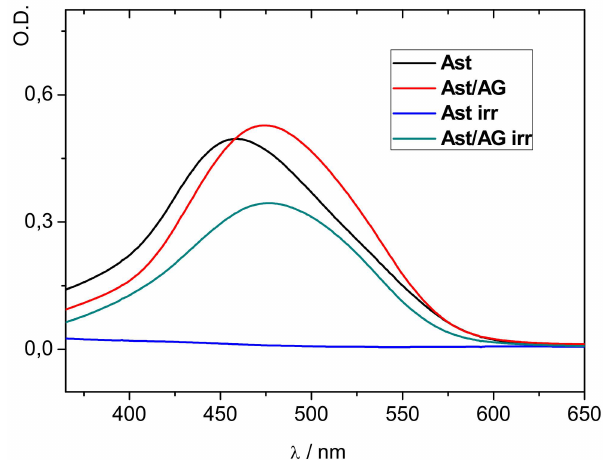
Figure 5. Photodegradation of astaxanthin in aerated 25% ethanol solution by the full light of a xenon lamp. Irradiation time 1 min (adopted from